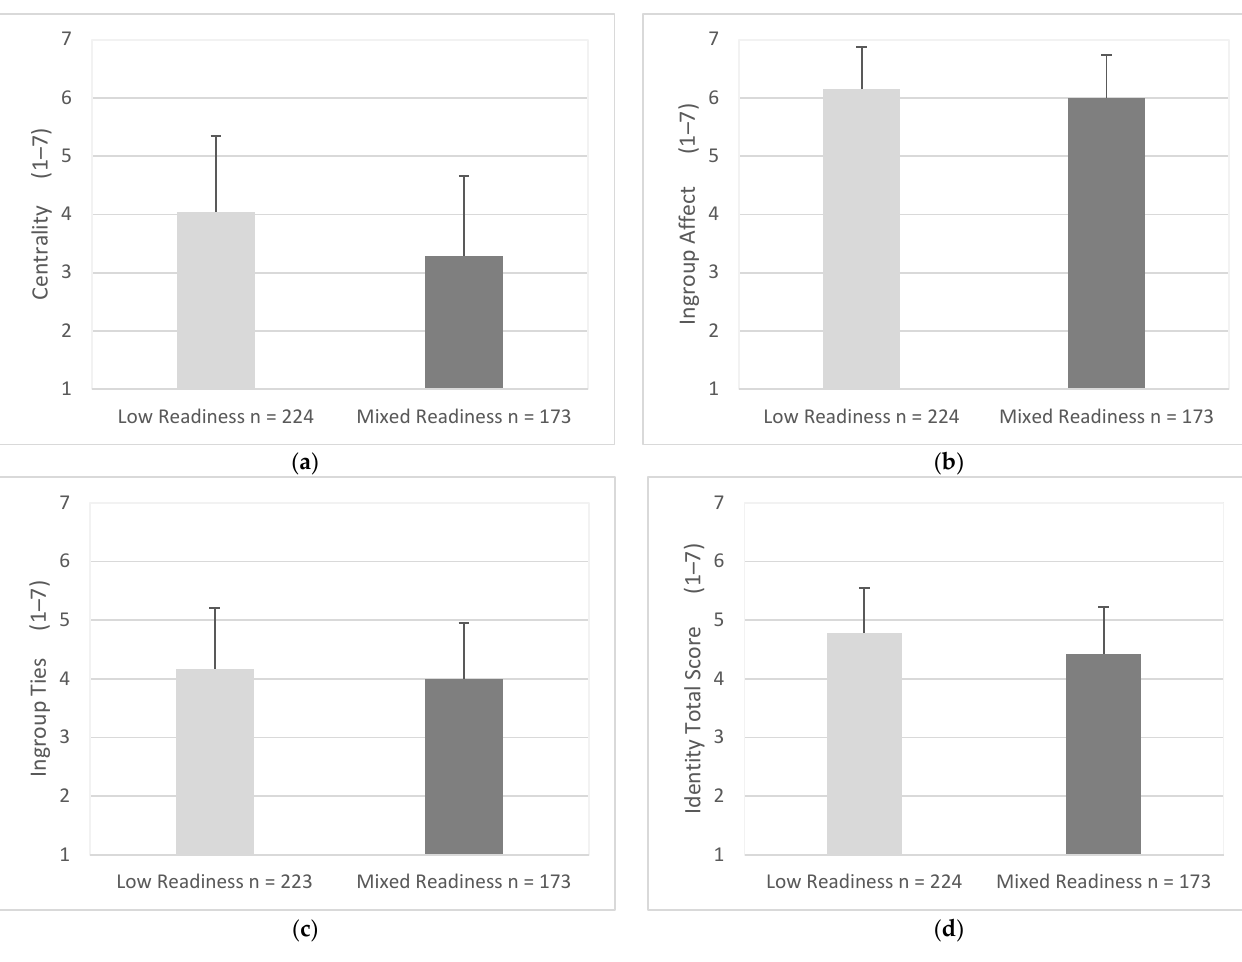
Figure 10. Mean score for identity factors and total scores as endorsed by participants for low readiness and mixed readiness for mobility change. Items were measured using responses of 1 (strongly disagree) to 7 (strongly agree). Error bars represent standard deviation. ( a ) Centrality, ( b ) Ingroup Affect, ( c ) Ingroup Ties, ( d ) Identity Total Score.